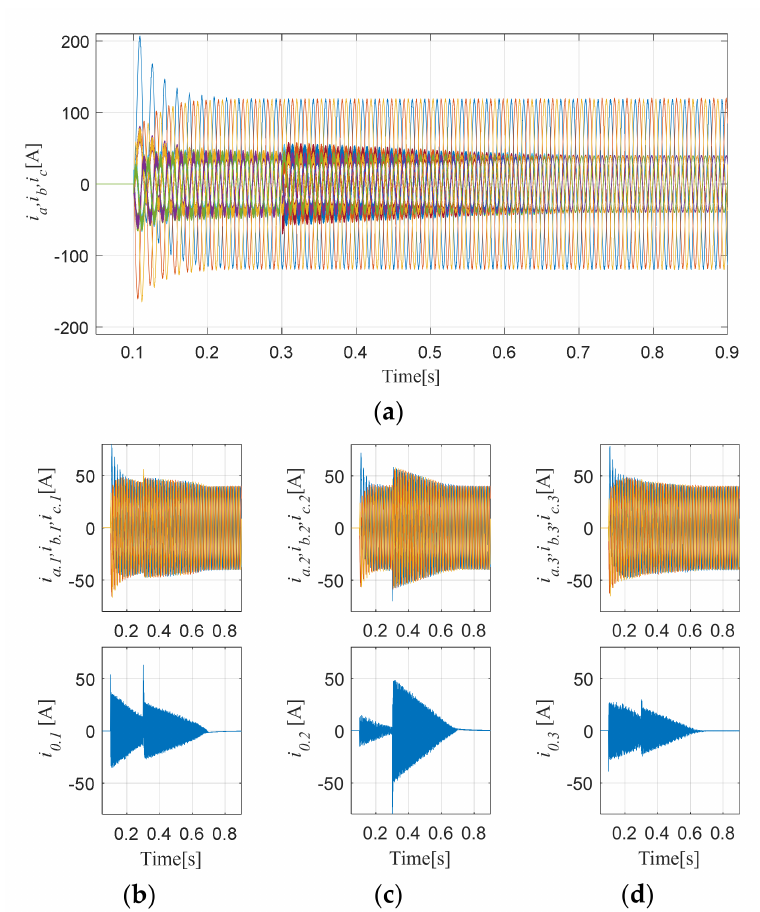
Figure 11. Result of simulation of control for phase error occurring during control operation 1 ( a ) Total inverter output current and the output currents of individual inverters, ( b ) output current and zero − sequence current of inverter 1, ( c ) output current and zero − sequence current of inverter 2, ( d ) output current and zero − sequence current of inverter